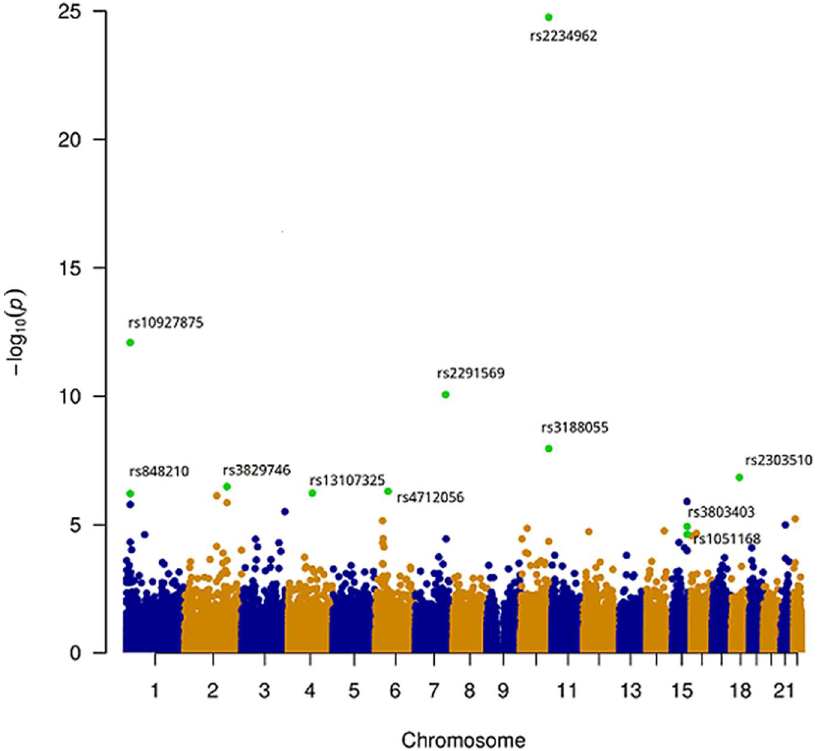
Fig 1. Manhattan Plot of association P-values. 95,499 variants were investigatedfor association with DCM by logistic regression analysis. Associations are summarized in a Manhattanplot (R/qqman package)which displaysthe elevenSNVs significantly associatedwith DCM (Q-values < 0.01) as green dots. Note that the appliedlogistic model assumed an additive mode of inheritance. For variants on chromosome15 in the ALPK3 region, a dominant mode of inheritancewas better supported by the data (see Table 1 for corresponding